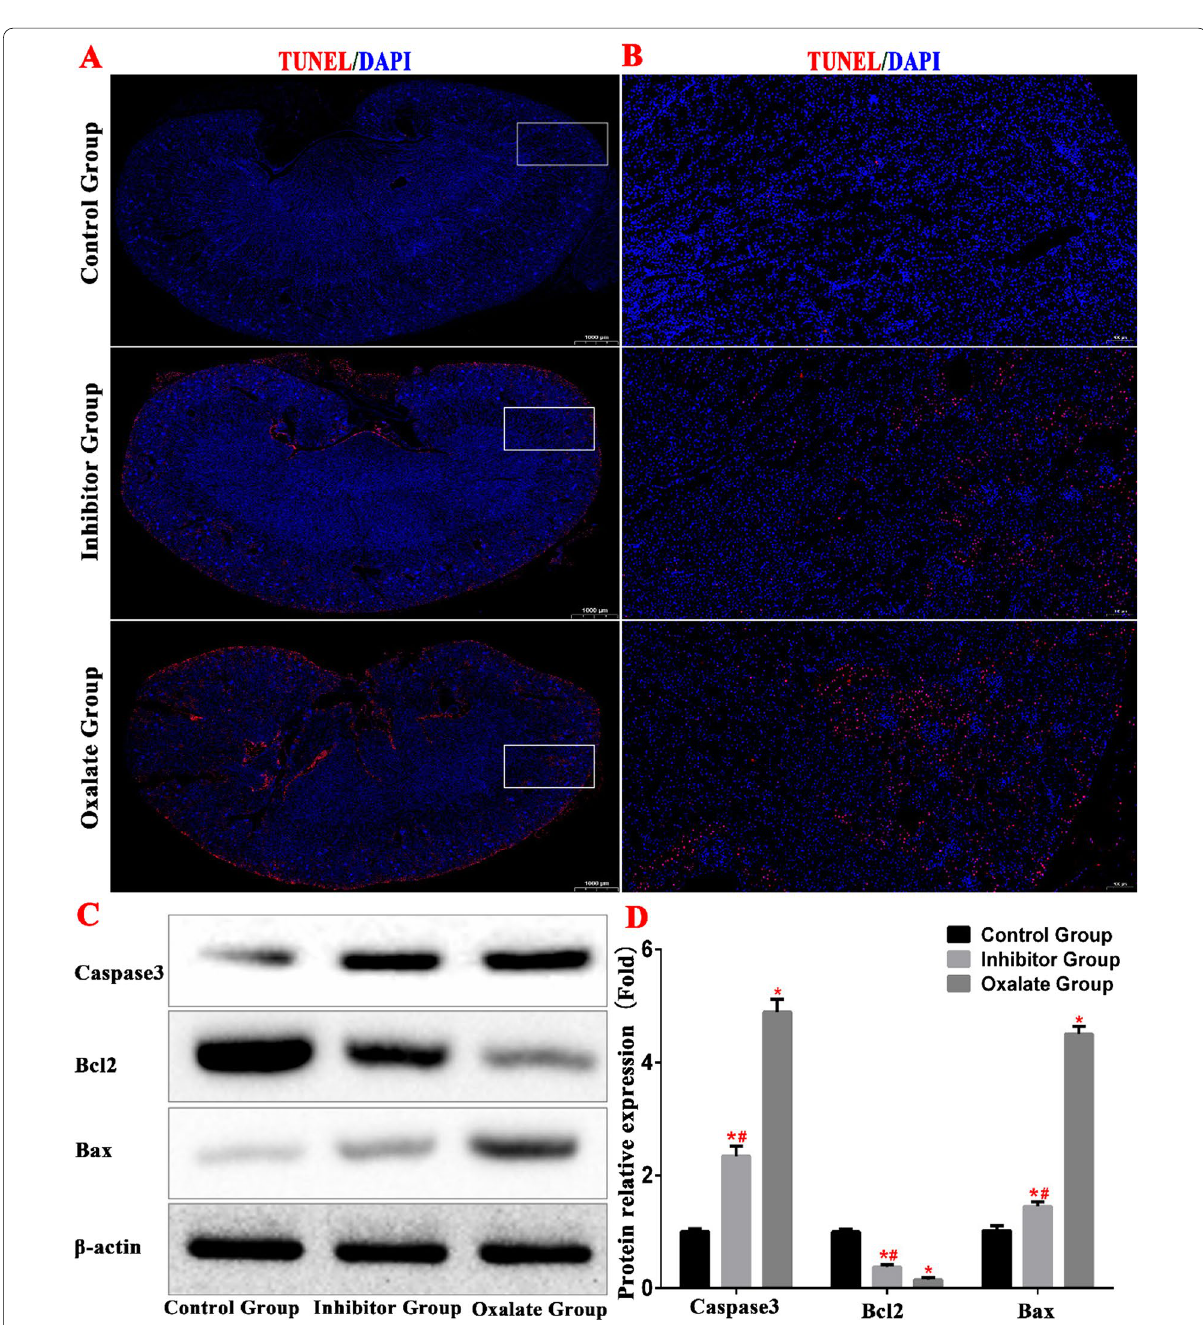
Fig. 3 A , B TUNEL staining was used to observe the renal apoptosis of mice in each group. C , D Western blot was used to detect the expression of apoptosis-related proteins. (* (Red) Compared with control group, P < 0.01. #(Red) Compared with oxalate group, P <